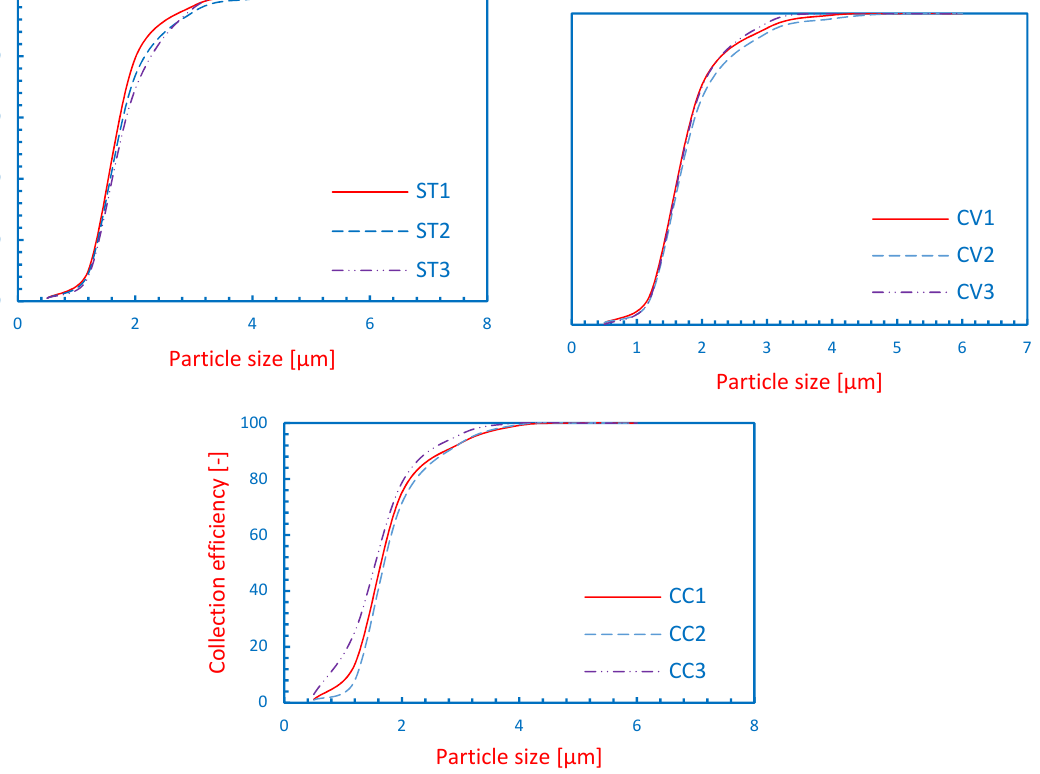
Figure 8. Grade efficiency curves for all cyclone models in ST variant, CV variant and CC variant at inlet velocities U in = 10 m/s with particle sizes ranging from 0.4 to 8.0 µm.